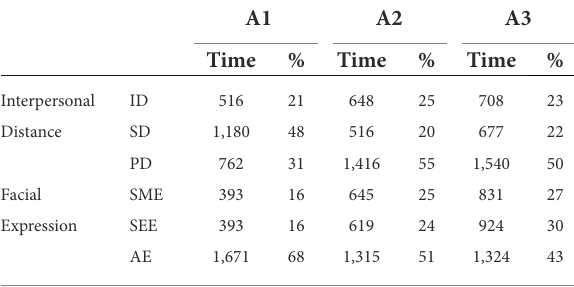
TABLE 7 Time changes in Teacher A’s three teaching